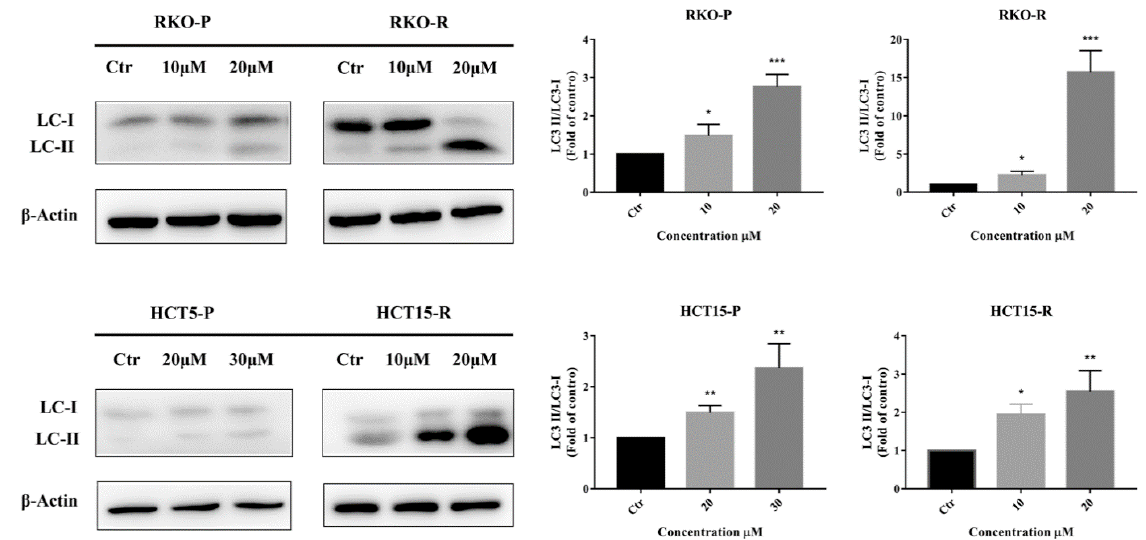
Figure 4. AGE activated autophagy pathway in 5-FU-sensitive/resistant CRC cell lines. Expression levels of LC3 II and LC3 I proteins were analyzed and, respectively, normalized by β -Actin after 24 h of AGE treatment. The ratio of LC3 II to LC3 I is shown in the right histogram. Results are expressed as mean ± SD ( n = 3). * p < 0.05, ** p < 0.01, *** p < 0.001, compared with Ctr group.